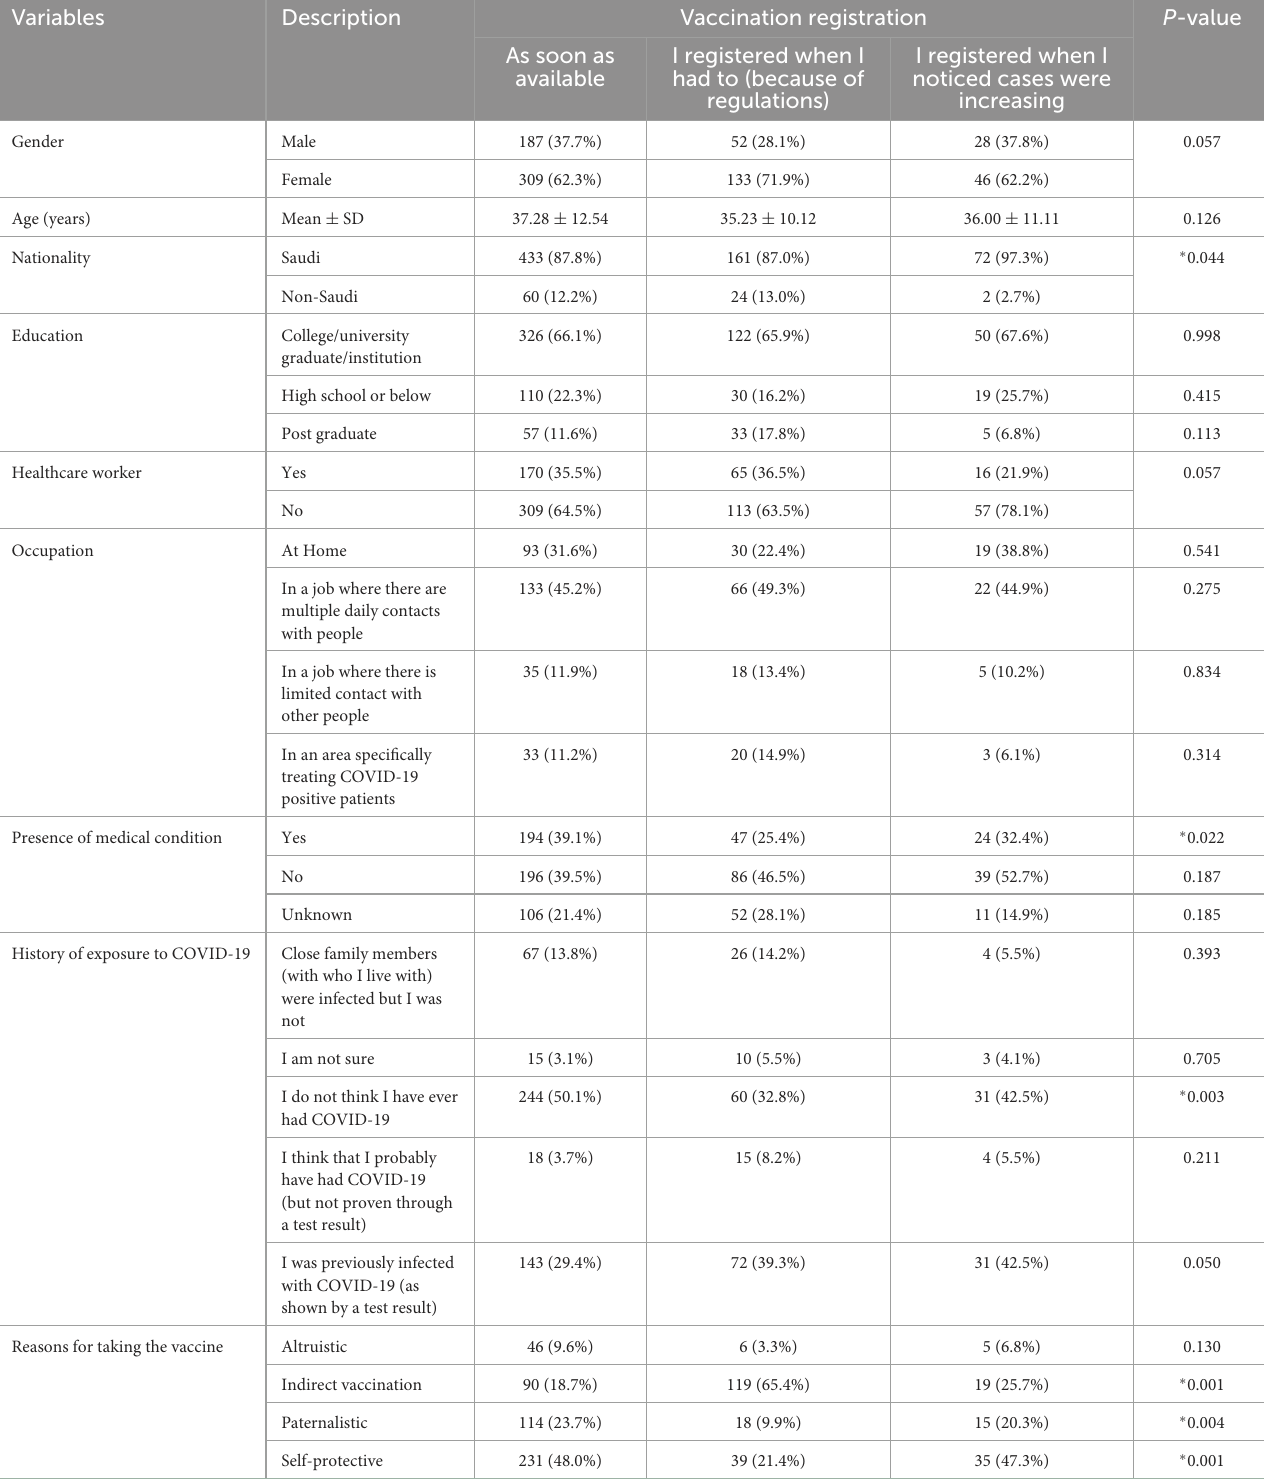
TABLE 3 Relationship between vaccine registration and demographic and clinical